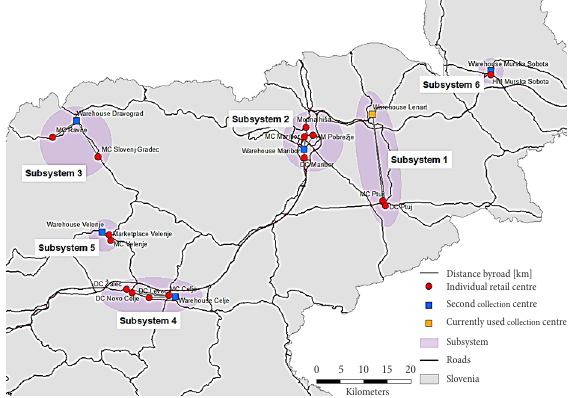
Figure 6. Display of an optimized